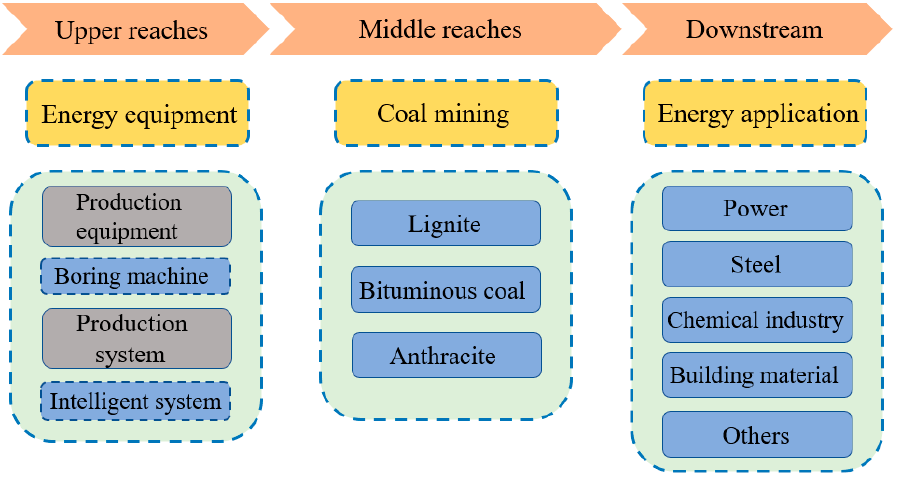
Figure 3. Coal energy industry production process.